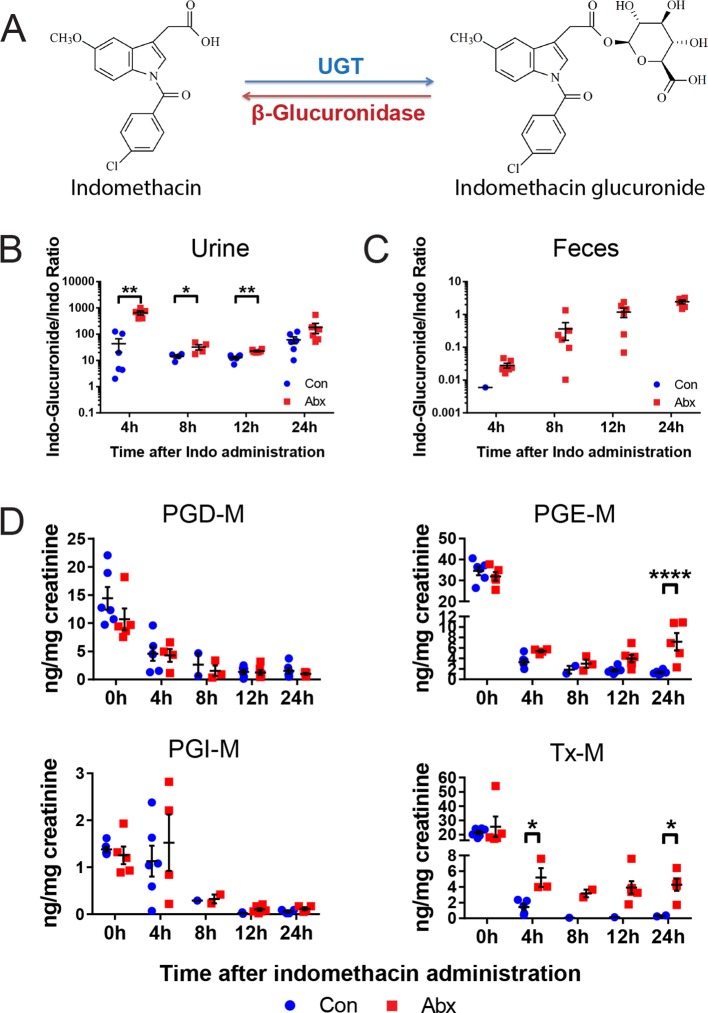
Metabolism and efficacy of indomethacin in antibiotic-treated mice are altered.Upon the cessation of 5-day treatment with antibiotic cocktail (Abx, neomycin and vancomycin) or control water (Con), mice were administered by gavage with 10 mg/kg indomethacin. Urine and feces were collected at indicated time for metabolic analysis. (A) Chemical structures of indomethacin (left) and indomethacin glucuronide (right). Enzyme catalyzing the glucuronidation is UDP-glucuronosyltransferase (UGT), and the one catalyzing the de-glucuronidation is β-glucuronidase. The ratio of indomethacin-glucuronide to indomethacin in urine (B) and feces (C) are higher in Abx group (red) than in Con group (blue). *p<0.05, **p<0.01 by Mann-Whitney test. N=6/group. Mean ± S.E.M. shown. (D) Urinary prostanoid metabolites were analyzed with LC/MS and values are corrected by creatinine. In Con mice (blue), all metabolites were reduced time-dependently. In Abx mice (red) PGD-M and PGI-M remained suppressed 24 hr after indomethacin, whereas PGE-M and Tx-M concentrations recovered more quickly. Two-way ANOVA revealed significant effect of time in PGD-M (p=0.001) and PGI-M (p=0.0004), and significant antibiotic effect of PGE-M (p<0.0001) and Tx-M (p=0.0002).In Abx mice, PGE-M was higher mice at 24 hr, and Tx-M was higher at 4 hr and 24 hr. N=6/group. *p<0.05, **p<0.01 by multiple comparison test, adjusted. Mean ± S.E.M. shown.